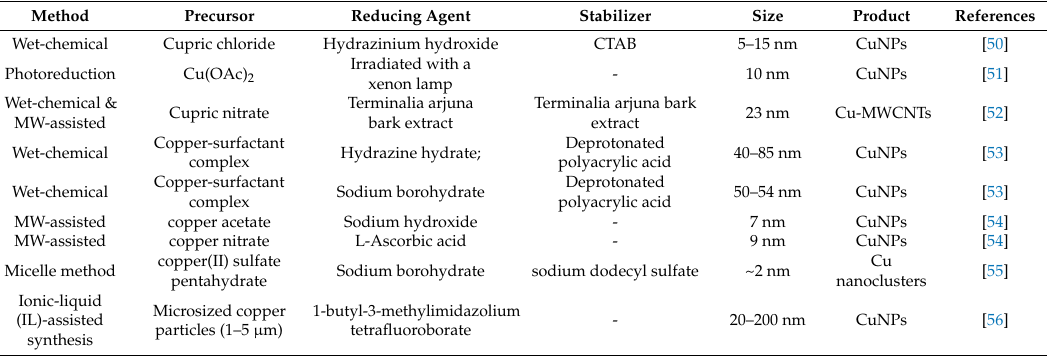
Table 3. Typical synthesis of copper